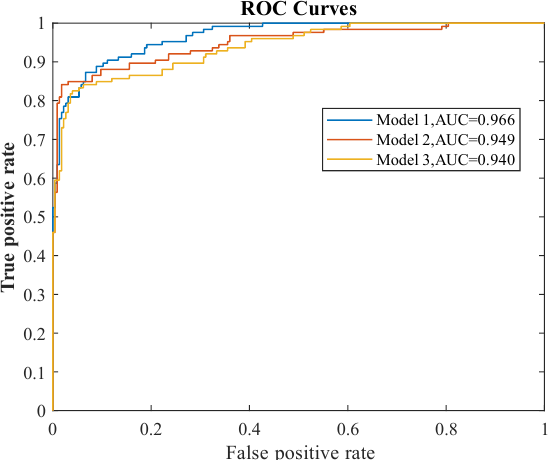
Figure A2. ROC curves for different models.